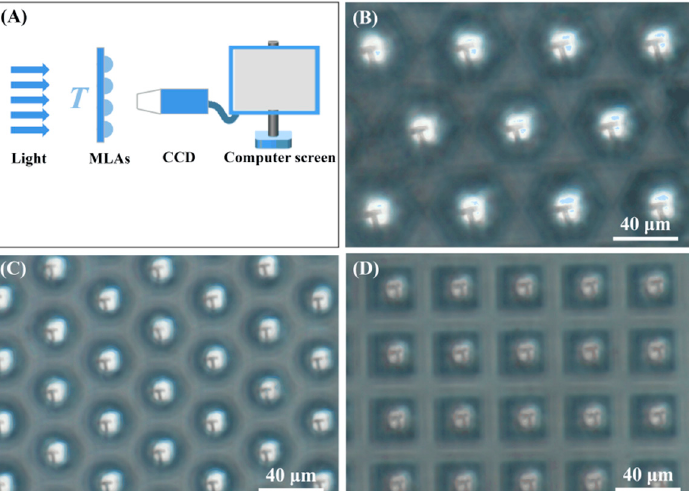
Figure 5. Diagram of the imaging system ( A ), and inverted images of a small lntin-foil with letter “T” imaged by the hybrid film MLAs, ( B ) hexagonal MLAs, ( C ) circular MLAs, and ( D ) square MLAs.